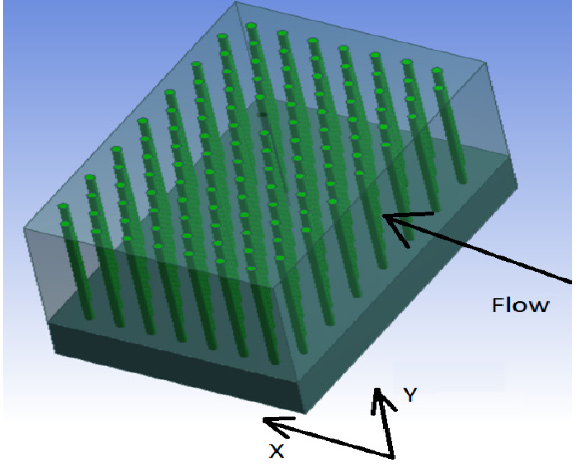
Figure 4. An equivalent-parallel-strands model for a metal foam block heated from the bottom. The x- and y-coordinates are measured in mm.